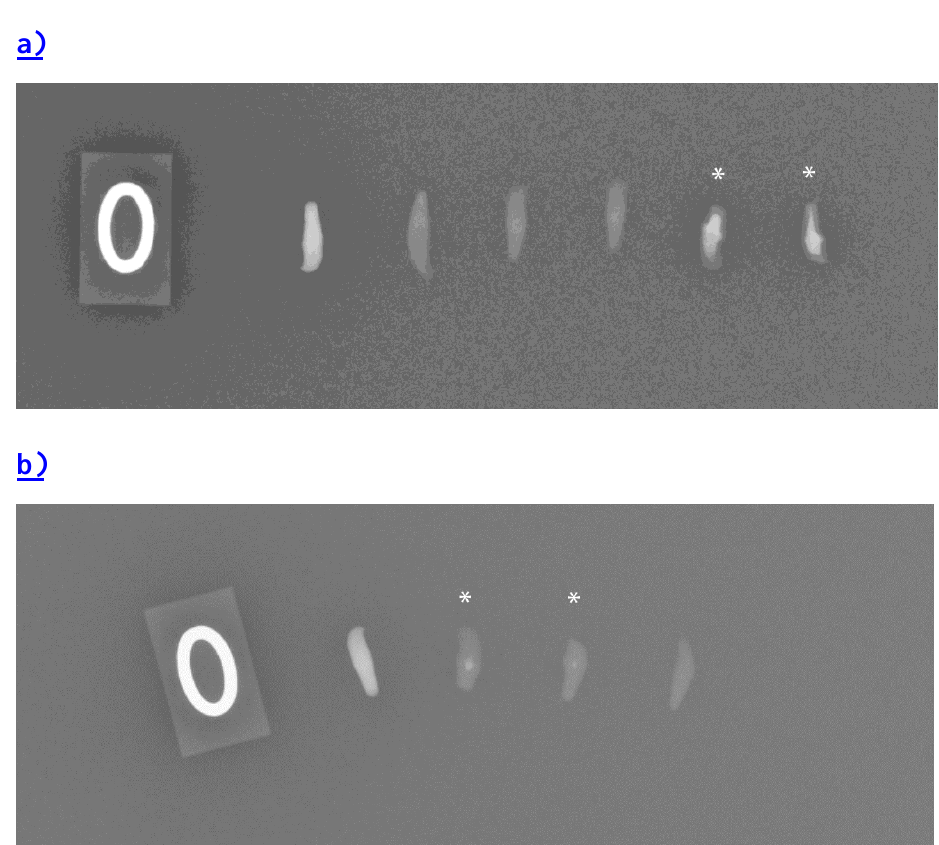
Fig. 1 . Radiology end point testing of Shona ’s teeth (a) after three weeks in 10% EDTA, changing the solution every 3-4 days and (b) after an additional two weeks in 10% EDTA. Shona ’s teeth are highlighted by asterisks and weighed approximately 120 g prior to